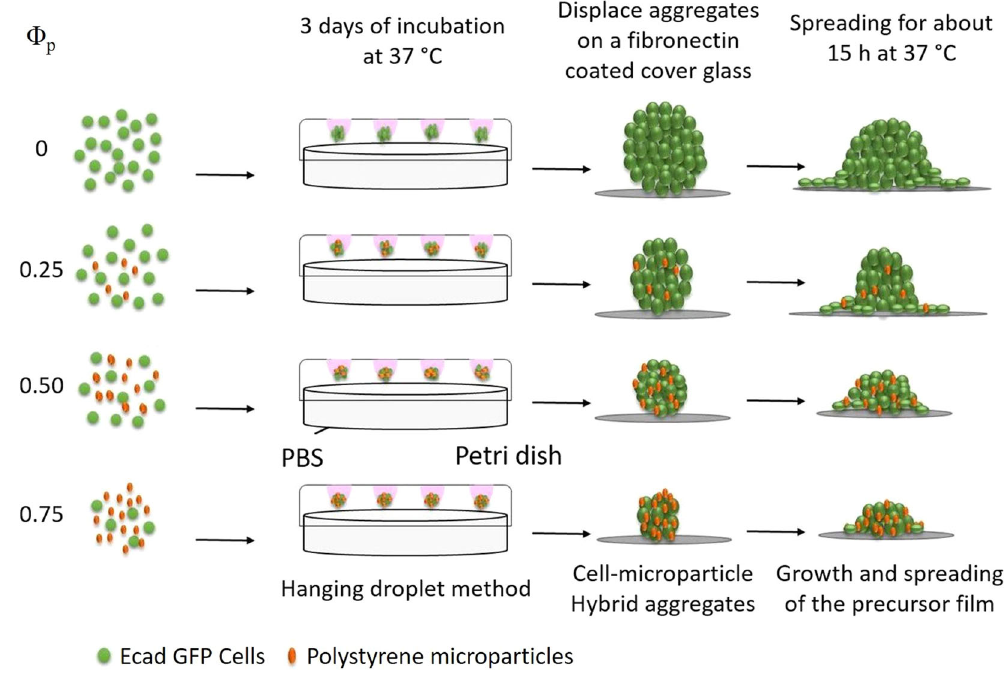
Fig. 4 Graphical representation of formation and spreading of the cell-microparticle hybrid aggregate. Φ v is the volume fraction of microparticles initially present in the hanging droplets. The total number of cells plus microparticles in each droplet is equal to 3.7 × 10 4 . Phosphate-buffered saline (PBS) is used to keep Petri dishes humidi fi ed.